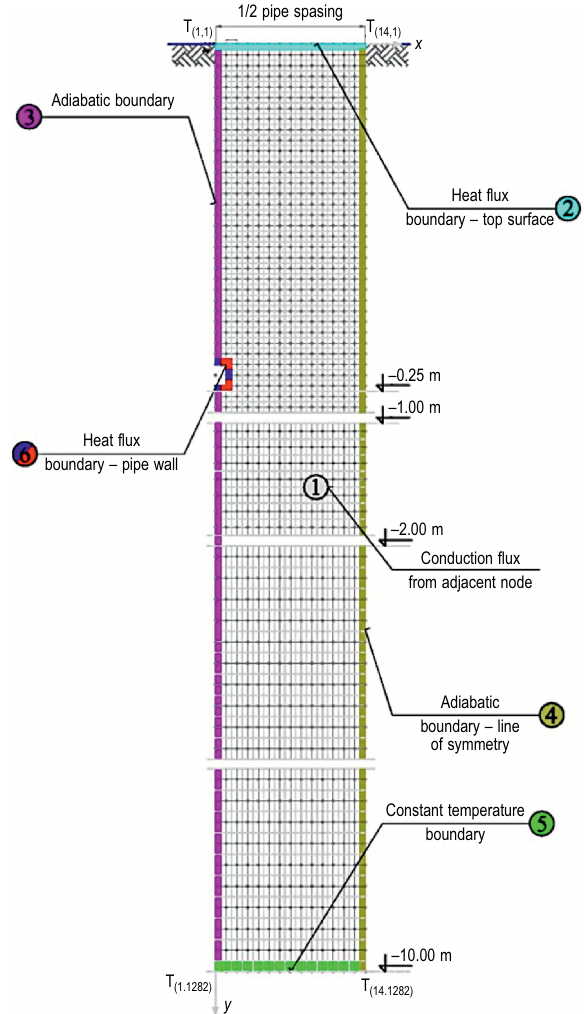
Fig. 2. The finite difference grid with boundary conditions